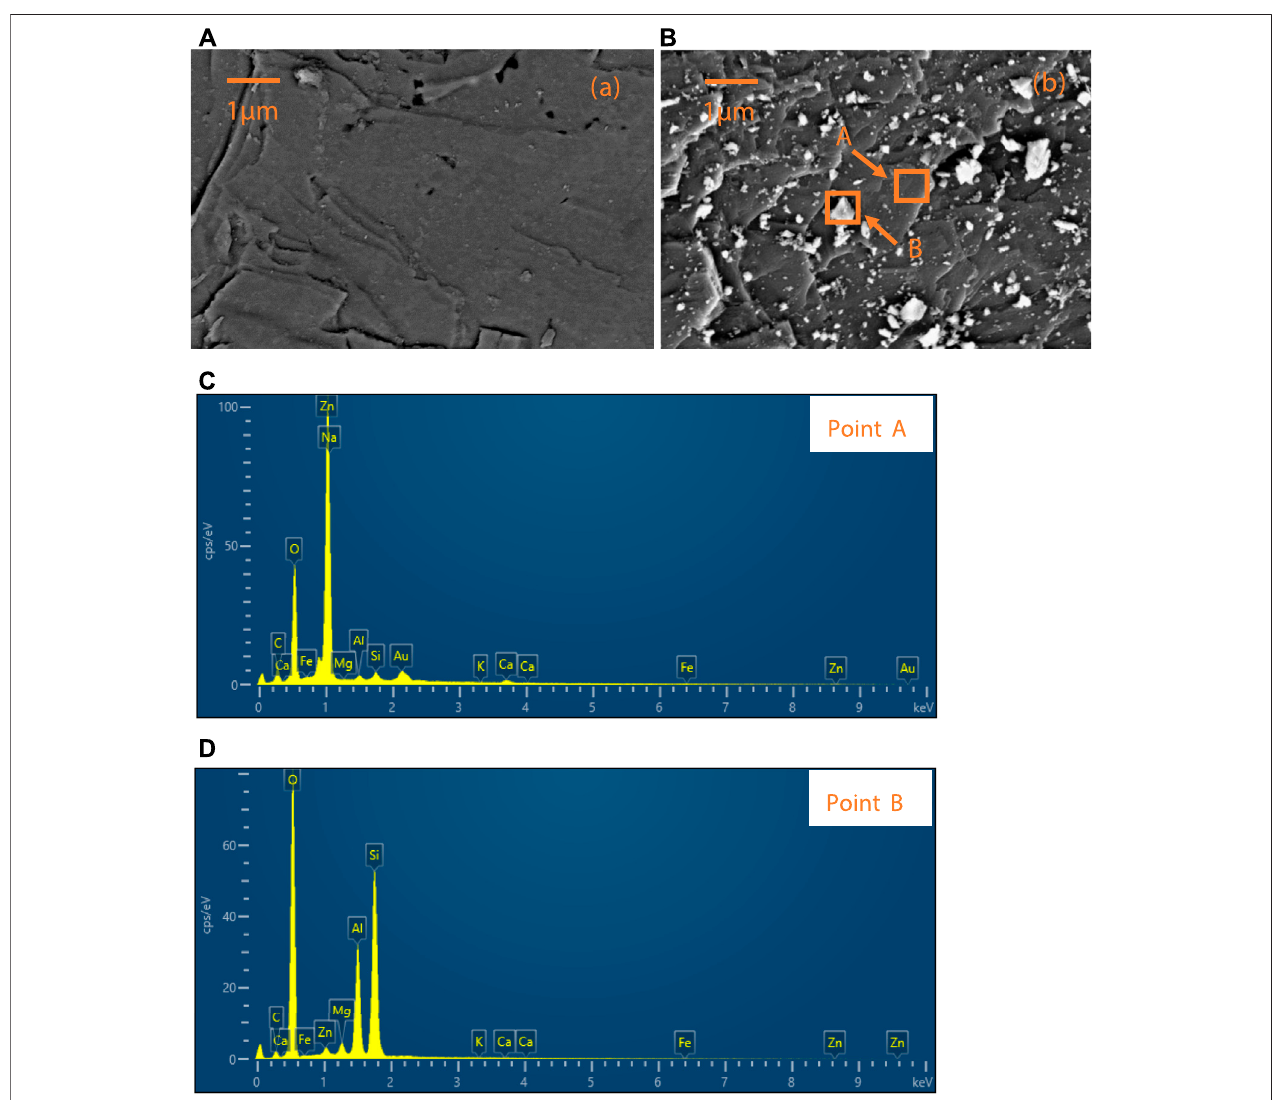
FIGURE7| (A) Quartz and (B) smithsonite surface after treatmentwith PNP,and theEDS results of (C) point Aand (D) point Bon thetreatedsmithsonite surface.